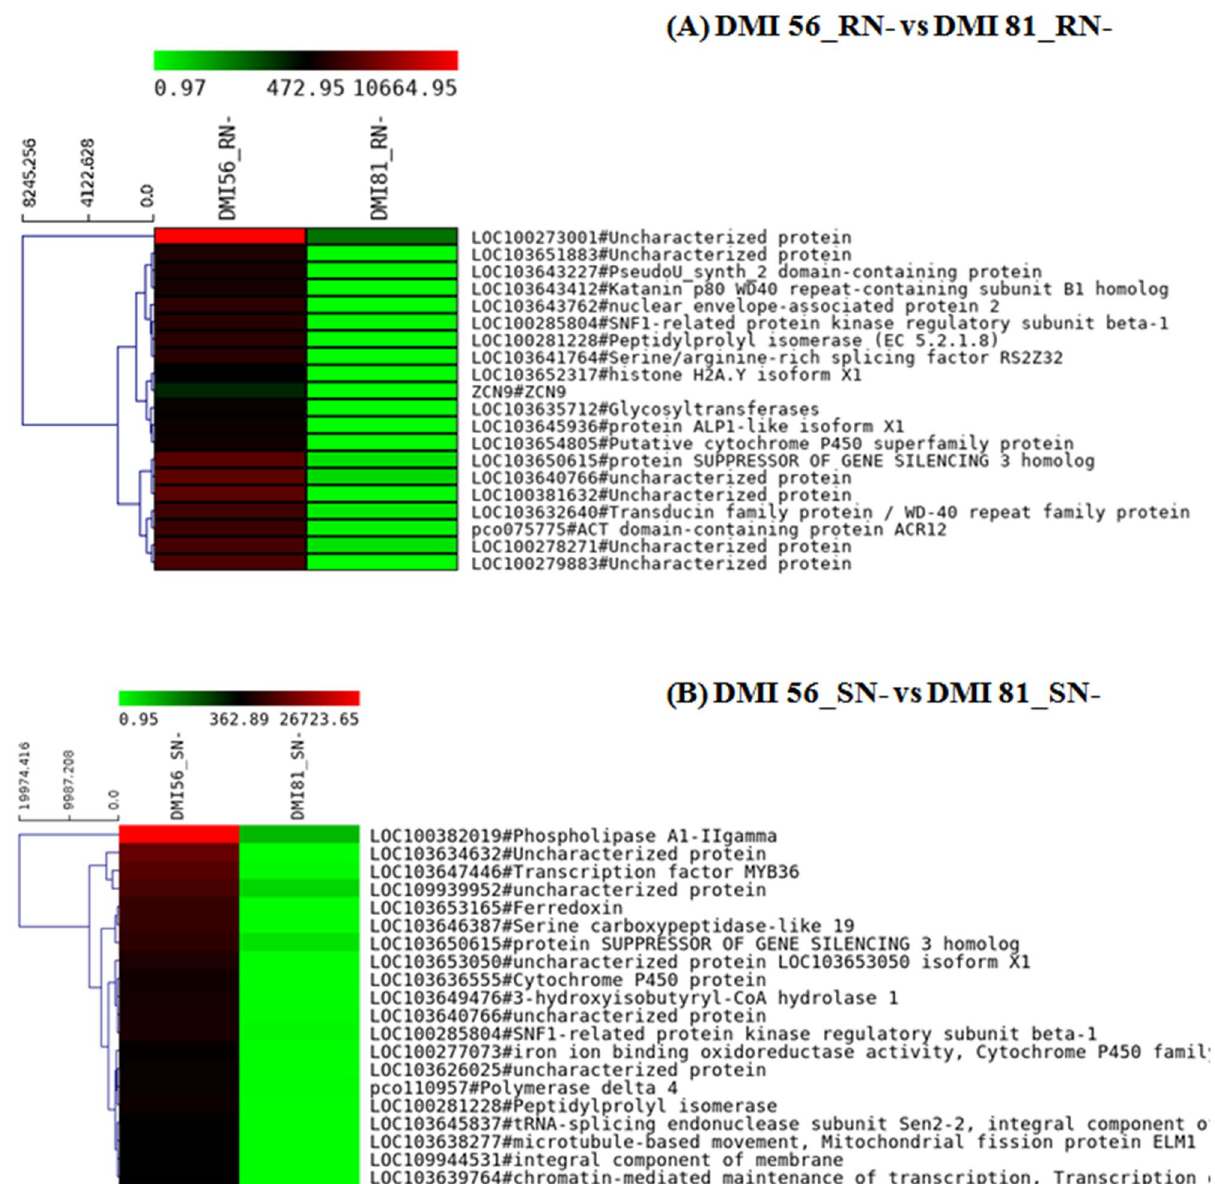
Figure 9. Heat map depicting top 20 up-regulated genes with p value < 0.05 in following combinations ( A ) (DMI 56_RN− vs DMI 81_RN−) and ( B ) DMI 56_SN− vs DMI 81_SN−). In the heat maps, each horizontal line refers to a gene. Relatively up-regulated genes are shown in red colour, whereas down-regulated genes are shown in green